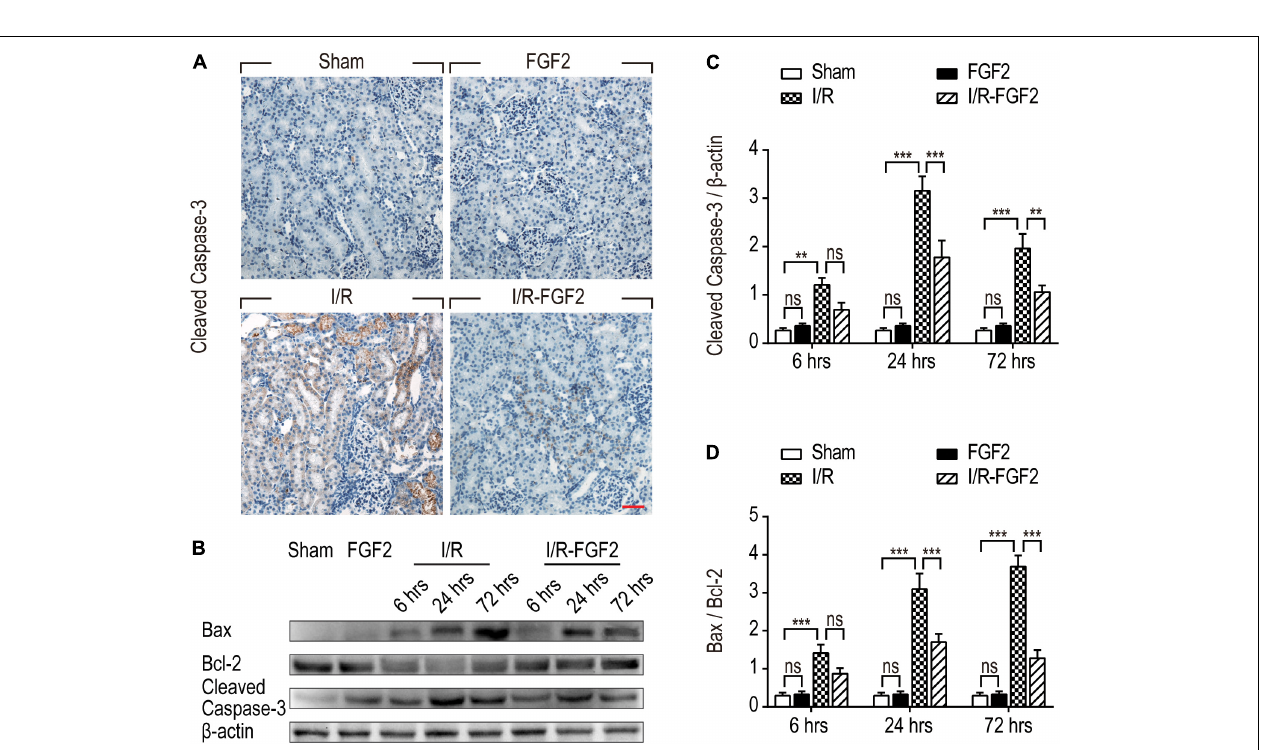
FIGURE 3 | Fibroblast growth factor 2 reduces the expression of pro-apoptotic proteins in kidney tissues. (A) Immunohistochemistry staining of cleaved Caspase-3 in kidney tissues at 24 h after reperfusion. The expression of cleaved Caspase-3 was detected in the cytoplasm of renal tubular cells in kidney tissues of the IR group. FGF2 treatment significantly attenuated the expression of cleaved Caspase-3. Images are representative of five animals in each group. Scale bar represents 50 µ m. (B) Western blotting analysis of expression of cleaved Caspase-3, Bax, and Bcl-2. Total kidney tissues including both cortex and medulla were used to analyze the expression of pro-apoptotic proteins in each group. µ -actinwas used as a loading control. (C,D) The bar charts show the normalized optical density analysis. FGF2 significantly reduced the expression of cleaved Caspase-3 and Bax compared with the I/R group. Representative data of five individual samples in each group. ** P < 0.01, *** P < 0.001; ns indicates not statistically significant.